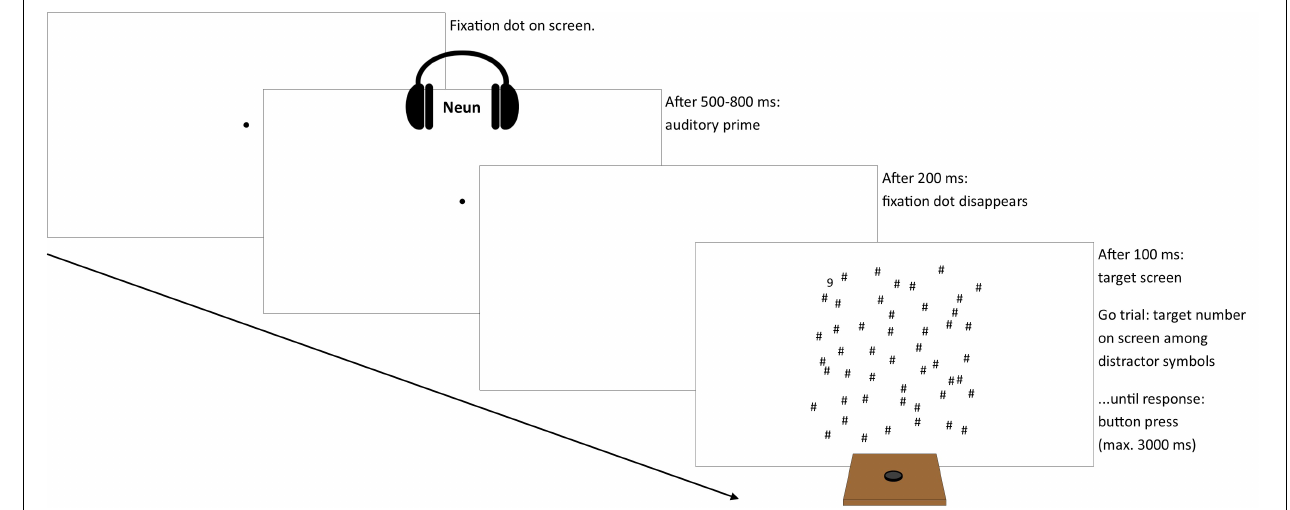
FIGURE 1 | Illustration of trial sequence (stimuli not to